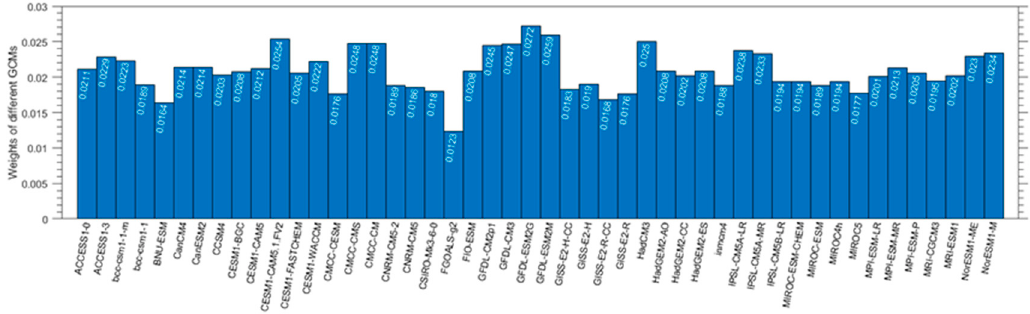
Figure 5. Relative weights of 48 GCMs calculated by the Bayesian model averaging (BMA) method.